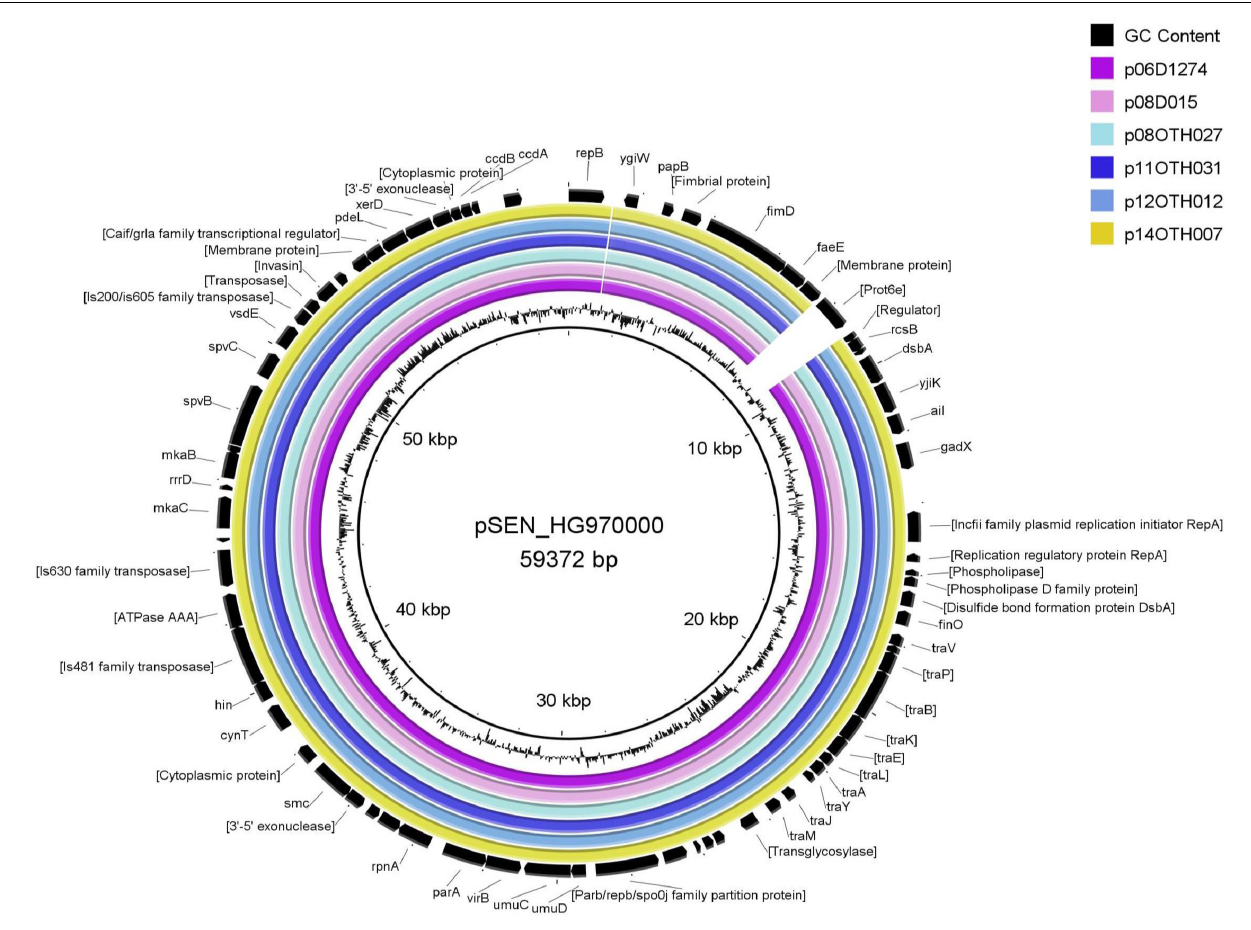
FIGURE 2 | BRIG diagram comparing unusual S . Enteritidis plasmid sequences with that of the reference plasmid pSEN. Colored rings represent 100% similarity to the reference